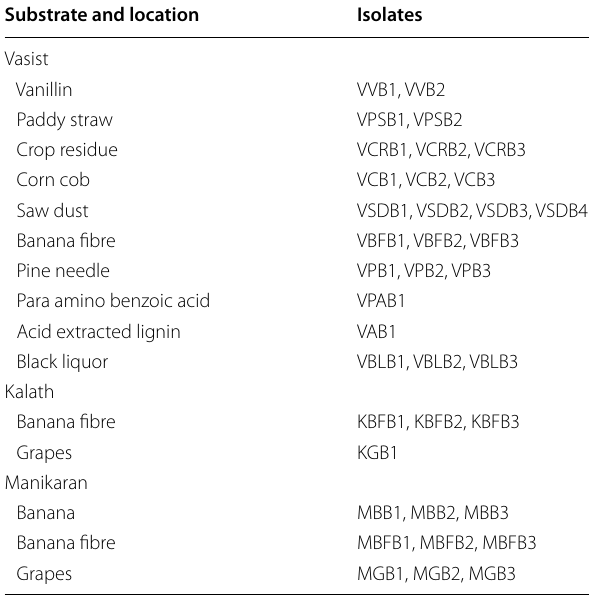
Table 1 Thermophilic bacterial isolates from hot springs isolated by in situ biotrap-enrichment